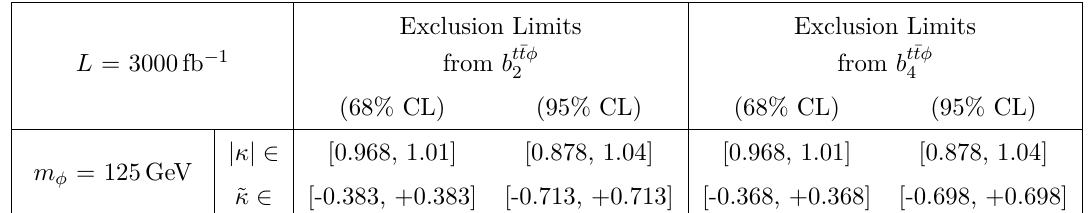
Table 3 . Expected exclusion limits for the t ¯ tφ CP-couplings for a fixed luminosity of 3000 fb − 1 . The limits are shown for 68% and 95% CL, for the variables b t ¯ tφ